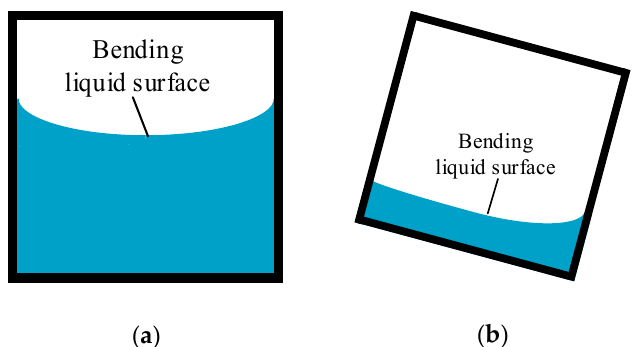
Figure 3. The influence of the surface adhesion effect. ( a ) Too small container size; ( b ) too shallow liquid depth.